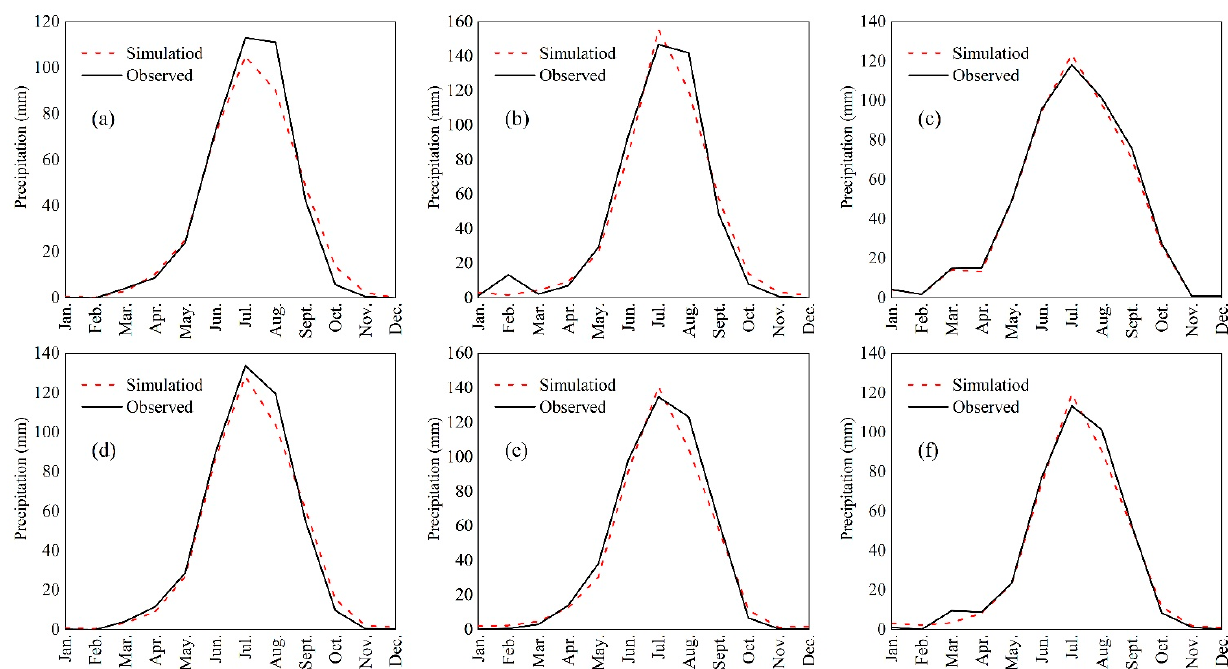
Figure 10. Measured values of monthly average precipitation from different meteorological stations, including the DLDQ station ( a ), LHASA station ( b ), NAGQU station ( c ), RRGB station ( d ), TANGJIA station ( e ), and YBJ station ( f ).